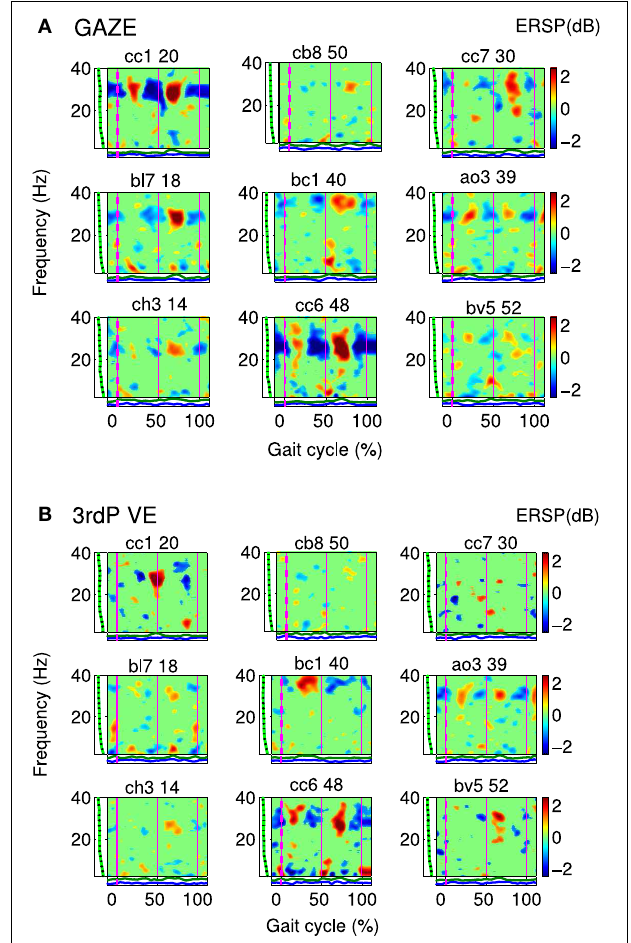
FIGURE 2 | Gait event-related spectral perturbation maps (ERSPs) for cluster A: Single IC plots showing significant changes in spectral power during the gait cycle for (A) GAZE and (B) 3rdP VE. Non-significant differences relative to the full gait cycle baseline ( p ≤ 0 . 05) are masked in green (0dB). Vertical lines mark the temporally aligned events of right leg heel contact as the beginning (0%) and end (100%) of the gait cycle, and the left heel-strike (50%). The gait-cycle related modulation in the 23–40Hz band is more pronounced during GAZE compared to 3rdP VE. The band in which this modulation appears varies over subjects and encompasses frequencies from 23 to 40Hz. [The codes on top of the figures (e.g., cc1 20) represent participant codes (e.g., cc1), and the number of the IC (e.g.,